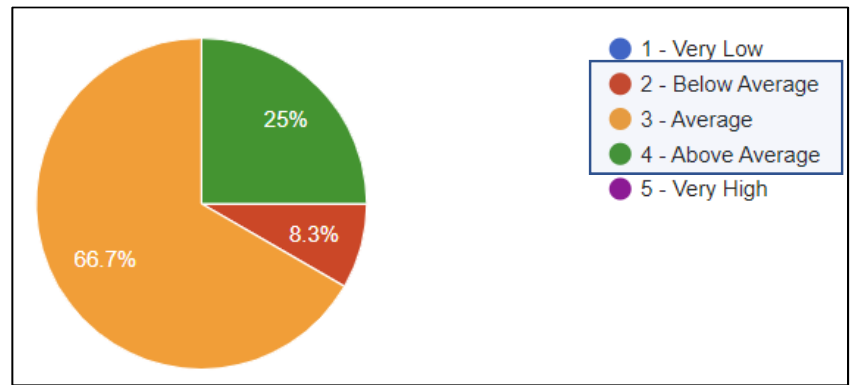
Figure 6. Students’ analysing skills before 1st smart classroom activity (Subject 1).